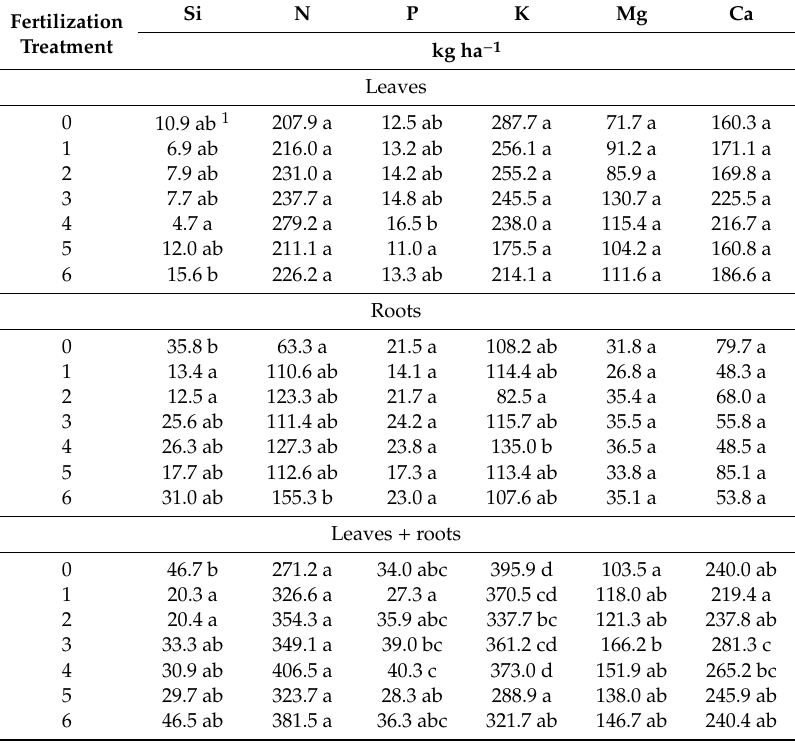
Table 2. Nutrient uptake by sugar beet plants (mean values from 2013 to 2014).